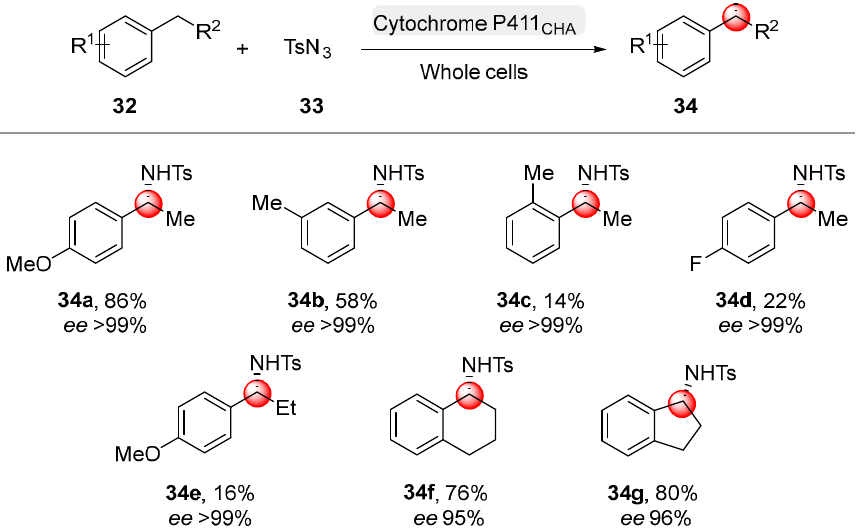
Scheme 18. Proposed mechanism for benzylic C ‒ H aminations.